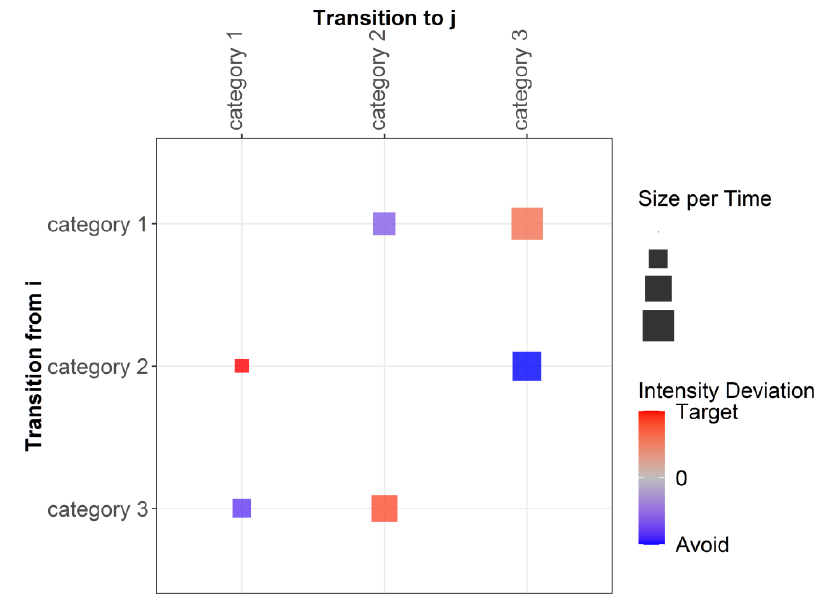
Figure 3. Structure of transition pattern.